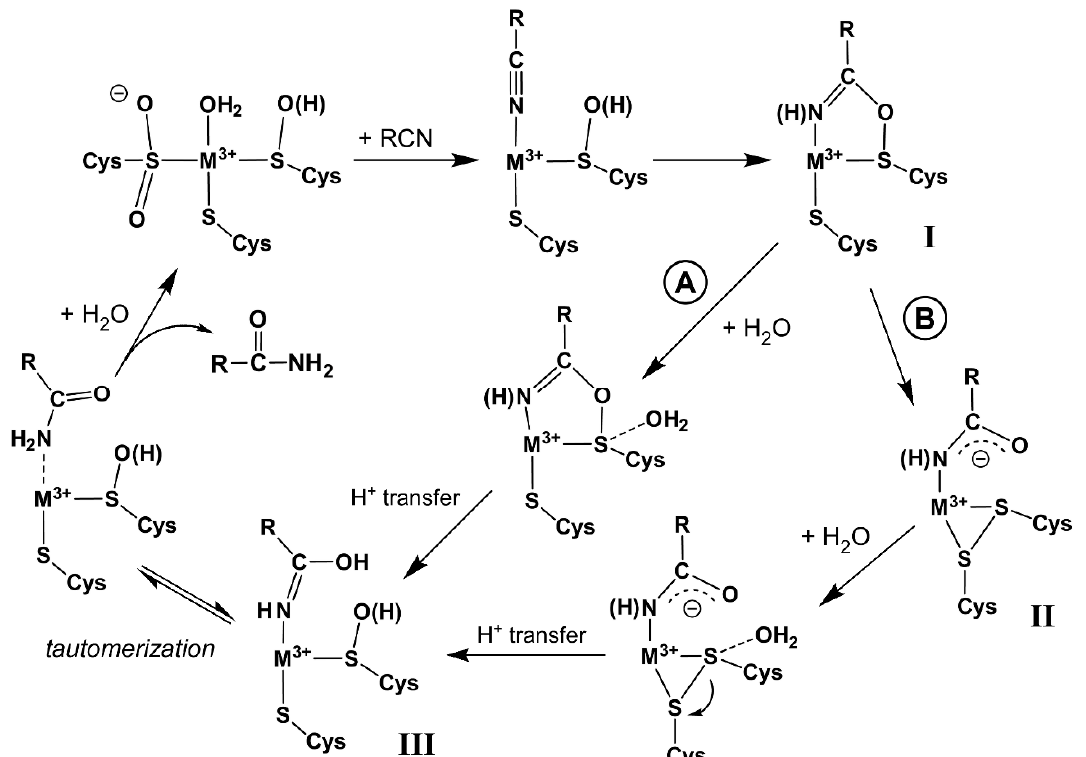
Figure 2. Proposed catalytic mechanism for NHase enzymes. Two possible pathways have been proposed and are labeled A and B. Within those pathways are several proposed intermediates of importance, which are labeled I, II, and III.